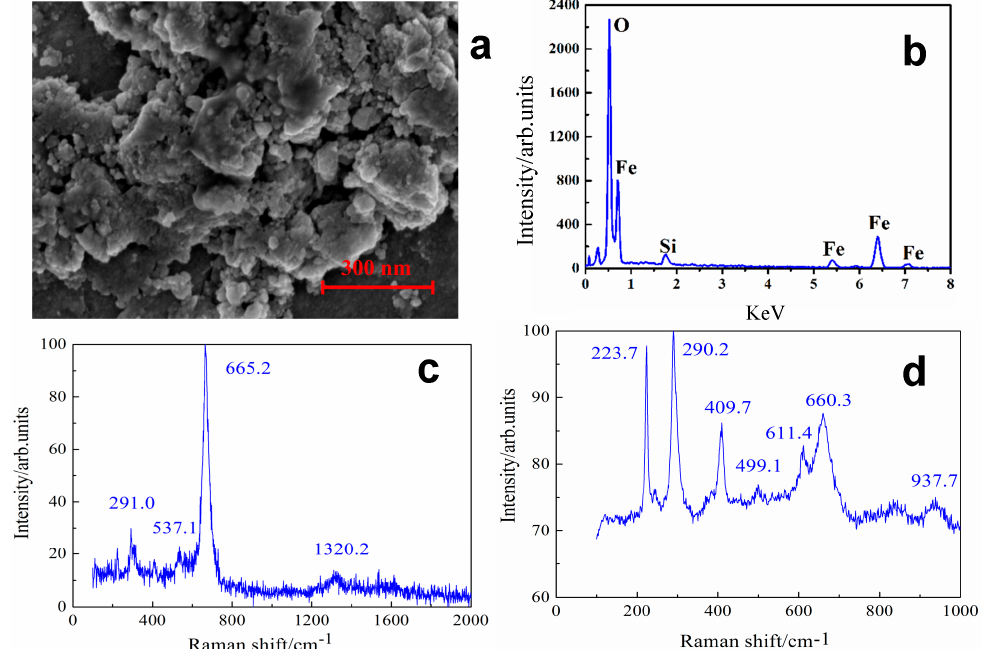
Figure 4. SEM images and EDS of wear scar of disc and Raman spectrum of steel ball/a-Si:H films: ( a ) SEM images and ( b ) EDS spectroscopy of wear scar disc at 600 °C. ( c ) Raman spectrum of wear scar on ball. ( d ) Raman spectrum of wear scar on disc.